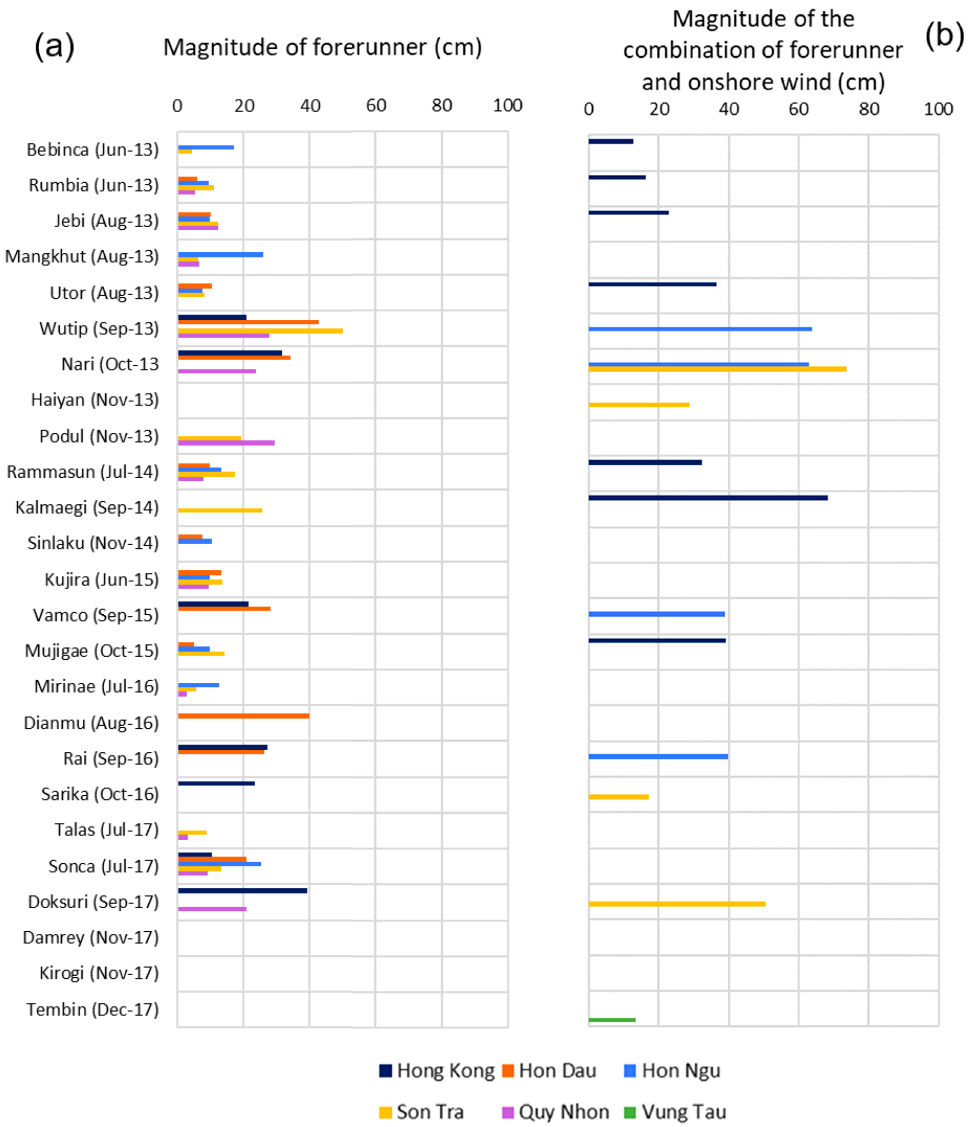
Figure 12. Magnitude of typhoons induced: ( a ) forerunner surge; and ( b ) combination of forerunner and onshore wind.